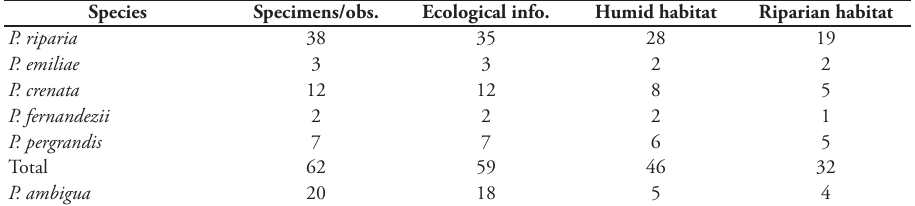
Table 3. Distribution of the georeferenced sample used for Ecological Niche Modeling and habitat infor- mation retrieved from voucher labels and aerial photographs (when geographic coordinates are very precise). Species Specimens/obs.